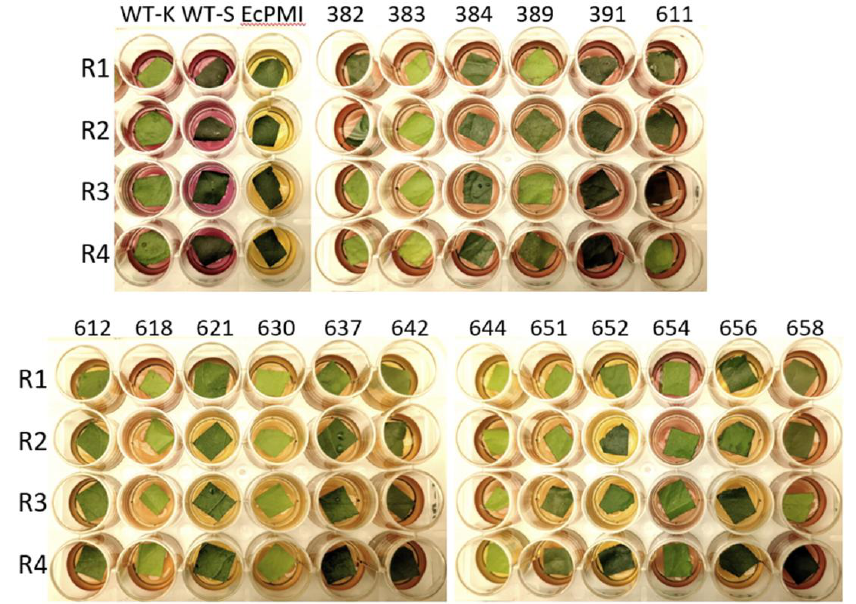
Figure 6. Chlorophenol red assay for phosphomannose isomerase (PMI) activity of citrus leaves. WT-K, non-transgenic mature Kuharske; WT-S, non-transgenic Swingle; EcPMI, positive control of transgenic Swingle obtained from another project; lines 382, 383, 384, 389, 391, 611 are the AtPMI2 transgenics; lines 612, 618, 621, 630, 637, 642 are the AtPMI2 transgenics; lines 644, 651, 652, 654, 656, 658 are the CsPMI1 transgenics; six independent transgenic lines of mature Kuharske were selected randomly and examined from each construct, four replicates from each plant. R1 to R4 are replicates.